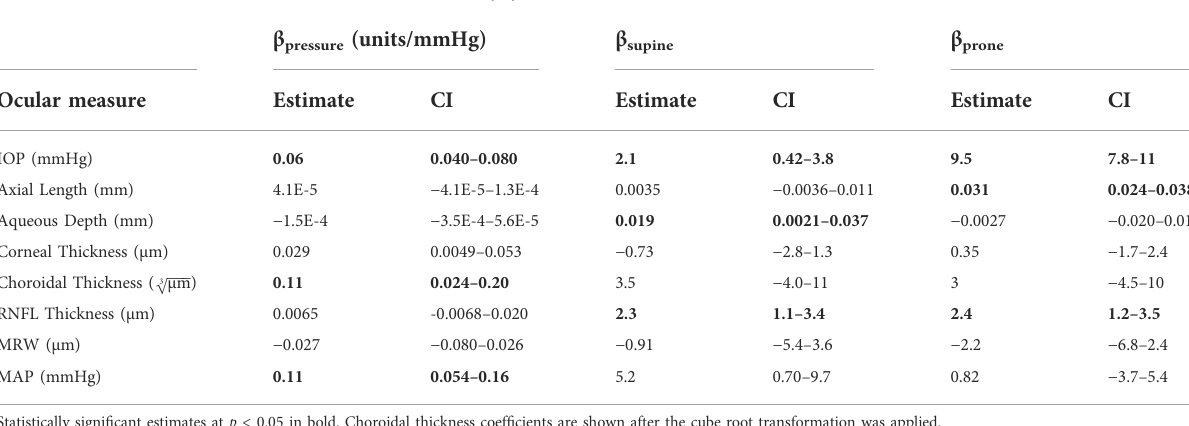
TABLE 2 Fixed effects coef fi cients and con fi dence intervals (CI) for linear mixed effects models.